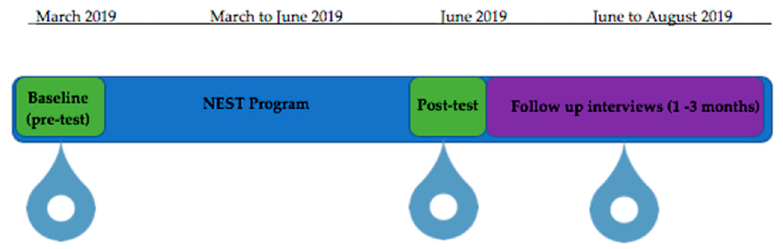
Figure 1. Study design and timeline.